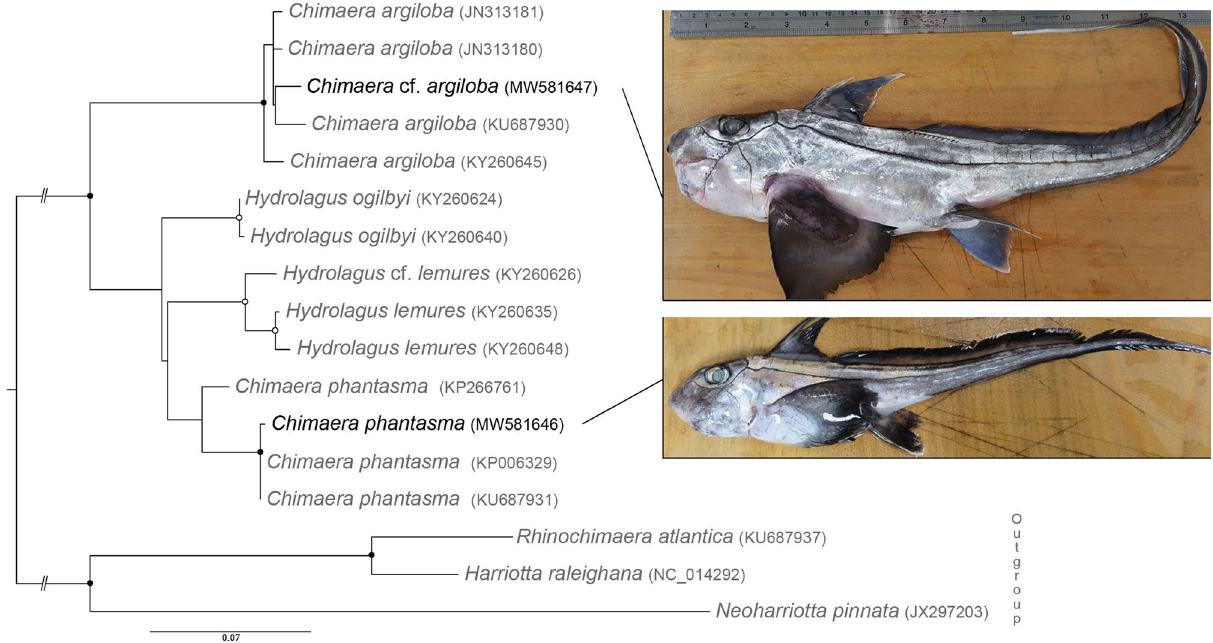
Figure 4. Hosts of gyrocotylideans off Taiwan and their phylogenetic positions. Maximum likelihood analysis on a partial COI gene dataset distinguished two host genotypes, i.e., Chimaera phantasma and C. cf. argiloba . Newly generated sequences are in black. The ultrafast bootstrap supports over 89% and 94% are depicted as open circles and black dots, respectively. The scale bar represents the number of substitutions. Numbers in parentheses are accession numbers in the GenBank